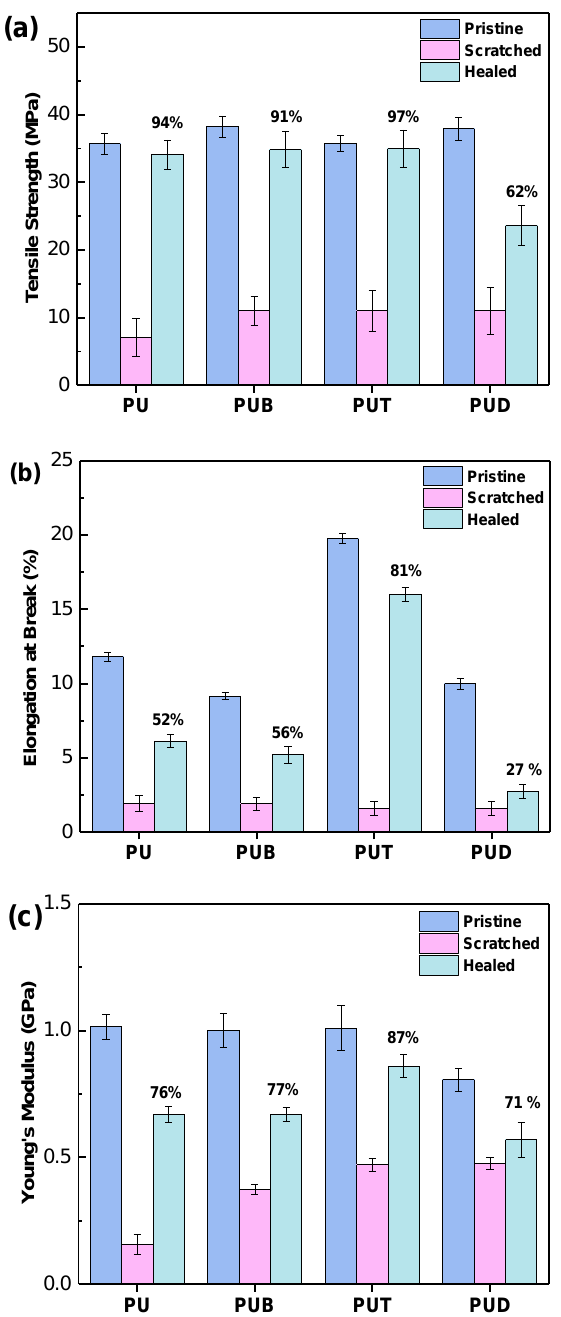
Figure 3. ( a ) Tensile strength, ( b ) elongation at break, and ( c ) Young’s modulus of PU, PUB, PUT, and PUD before and after the self-healing process. All data points were obtained by averaging the results of five measurements.